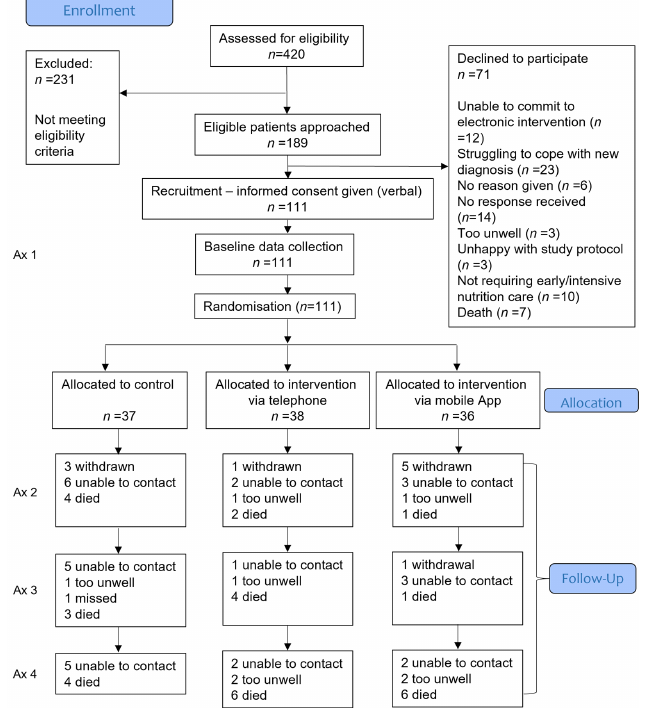
Figure 1. Flowchart of participants over the 12-month follow-up. Multiple imputation was used to replace missing individual data points (other than due to death) for conducting comparisons in mean QALY per participant between groups. Secondary data were analysed without imputation for missing data. Ax, assessment.